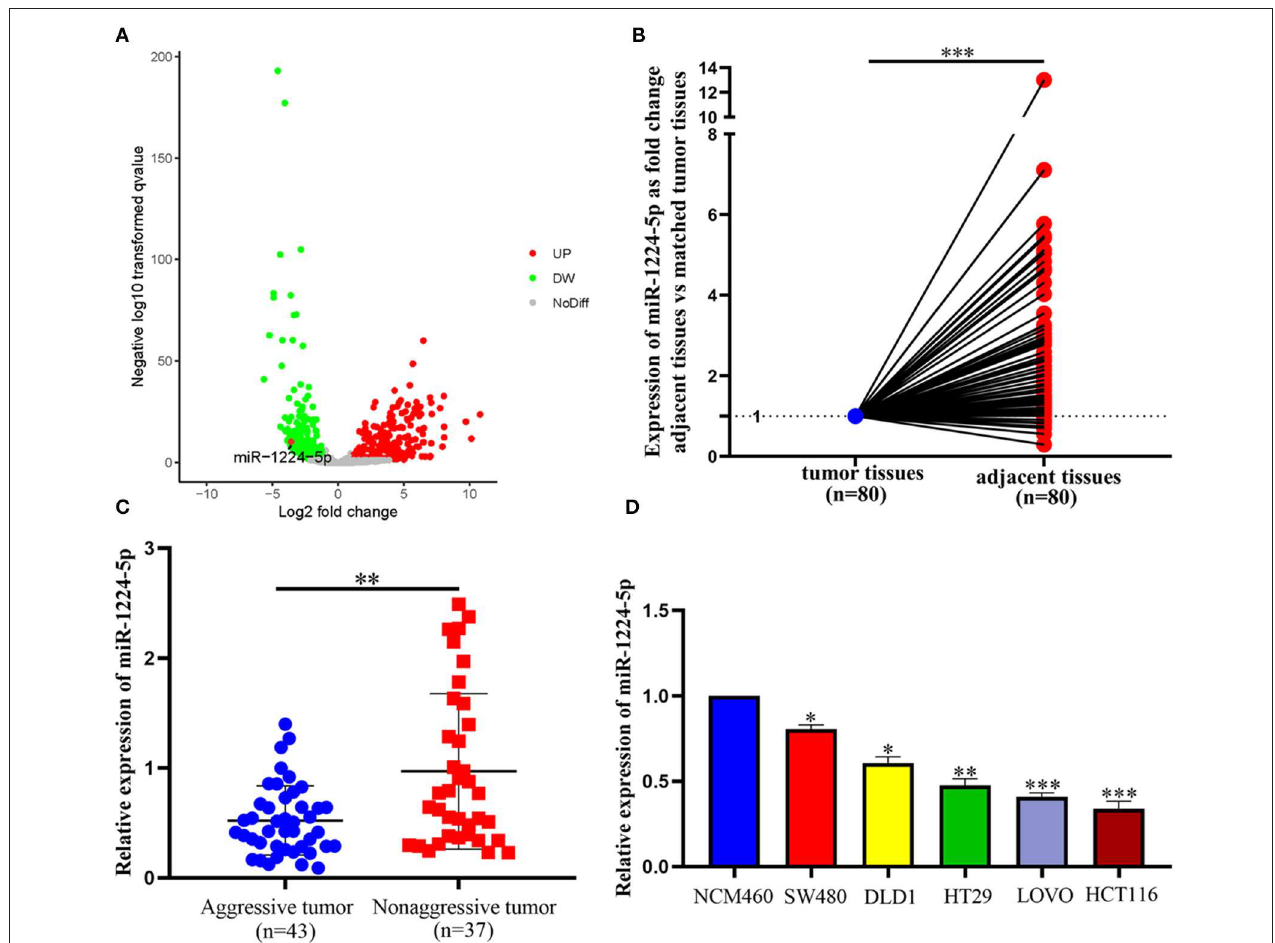
FIGURE 1 | miR-1224-5p is underexpressed in CRC tissues and CRC cell lines. (A) miR-1224-5p expression in 457 CRC and 7 non-tumor colorectal tissues from TCGA data. (B) miR-1224-5p expression in 80 paired CRC tissues and adjacent normal tissues. (C) miR-1224-5p expression in aggressive and non-aggressive CRC tissues. (D) miR-1224-5p expression in CRC cell lines and normal epithelial colon cell NCM460. Data represent the mean ± SD from three independent experiments. Student’s t -test was used to determine statistical significance: * p < 0.05, ** p < 0.01, and *** p <